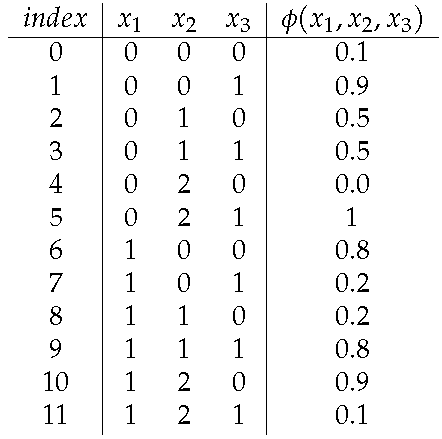
Figure 1. Representation of the potential φ ( X 1 , X 2 , X 3 ) as a mapping that assigns a numeric value to each